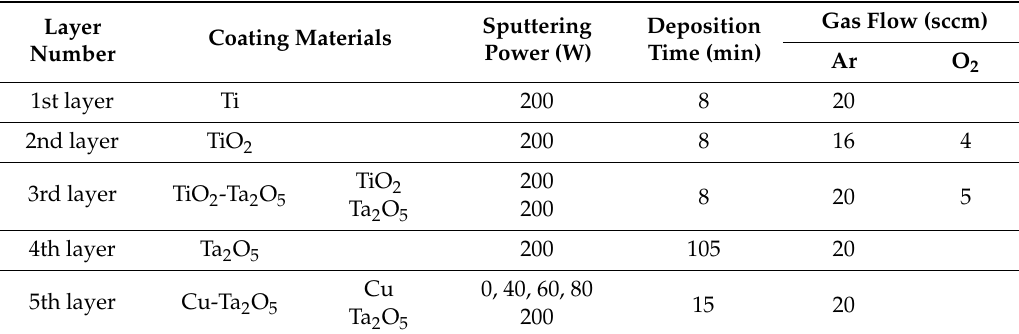
Figure 3. Schematic diagram of the deposition sequence of each film layer in Cu-MTa 2 O 5 multilayer composite coatings. Table 1. Coating preparation parameters.